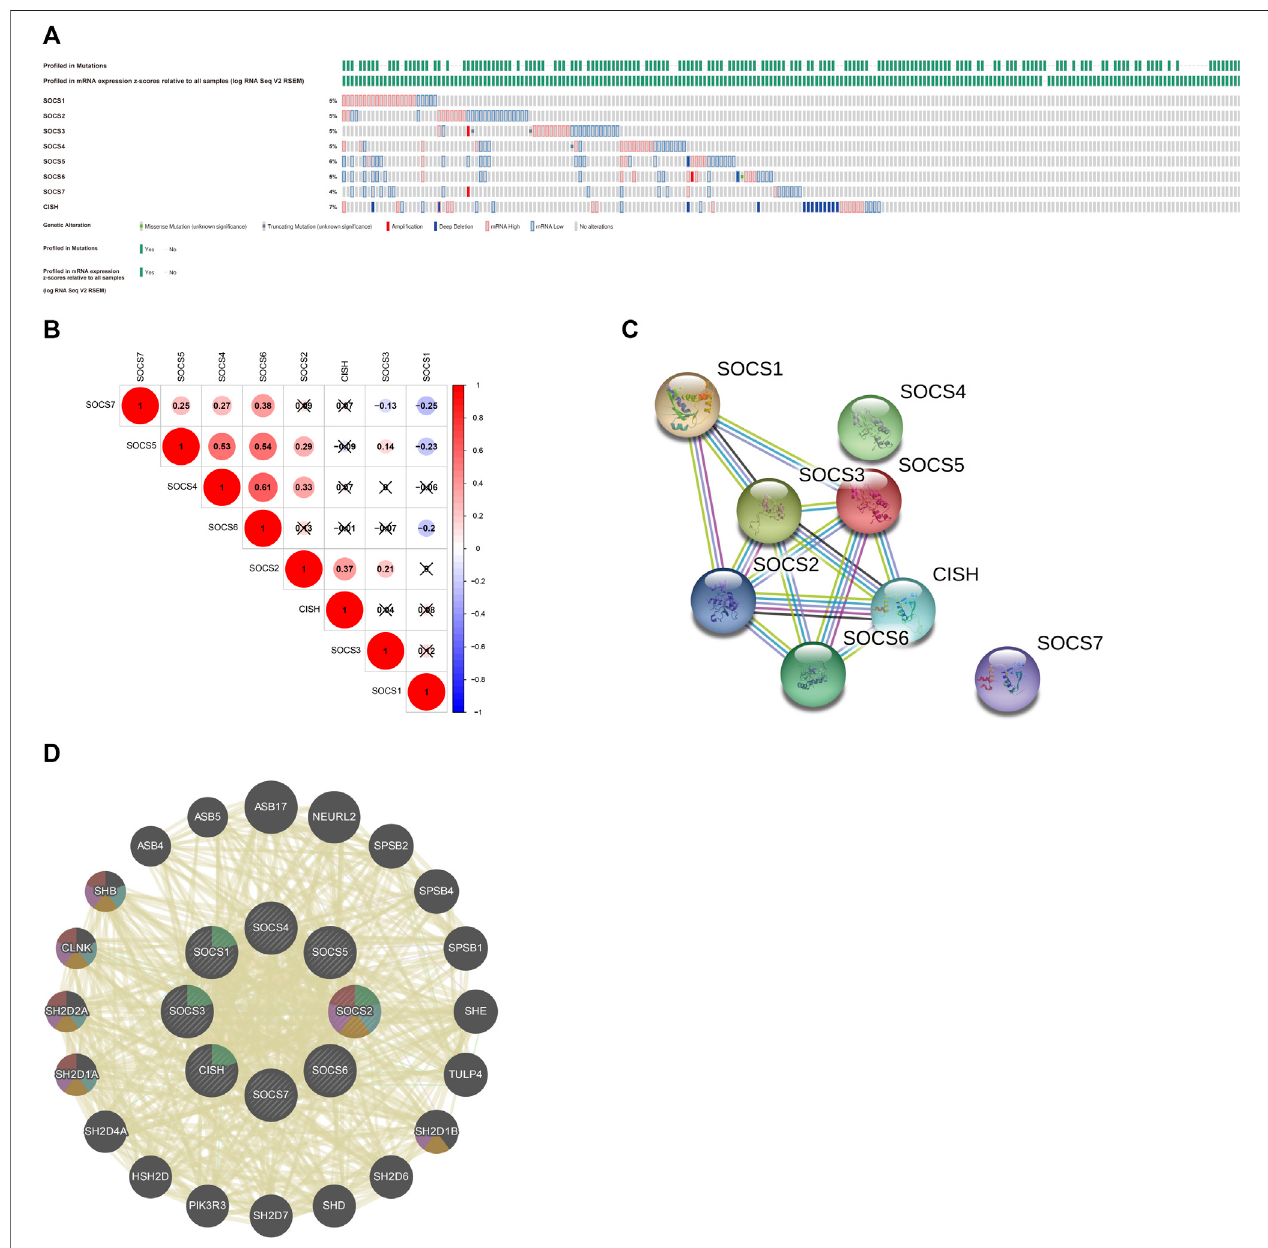
FIGURE4|(A) GeneticalterationsofdifferentSOCSfamilymembersinKIRC. (B) Potentialco-expressionanalysisindicatedasigni fi cantcorrelationwasobserved among SOCS4 , SOCS5 , and SOCS6 . (C) Protein – protein interaction network demonstrated SOCS2 , SOCS3 , and SOCS5 were possibly hub genes among these SOCS family members. (D) SOCS family members were predominantly related to protein binding, SH3/SH2 adapter activity, signaling adapter activity, and JAK/STAT cascade.